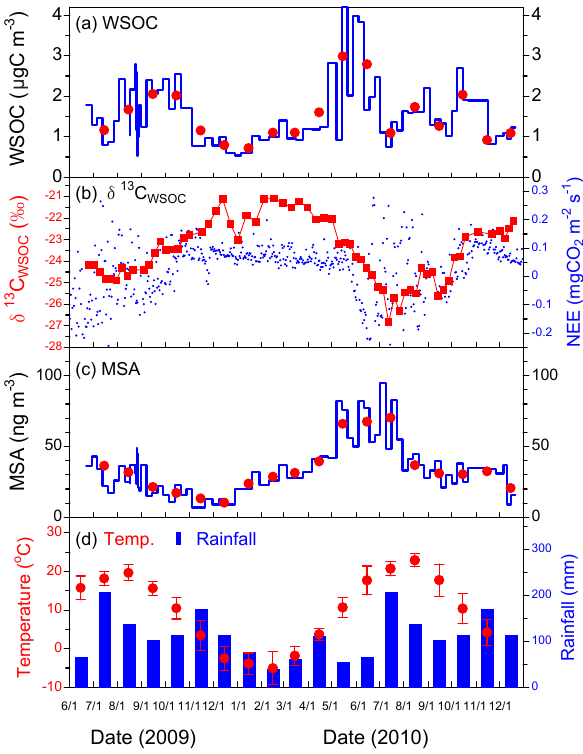
Fig. 2. Temporal variations of (a) WSOC, (b) δ 13 C WSOC (red solid squares) and NEE (blue dots), (c) MSA, and (d) ambient tempera- ture and rainfall near the ground surface at a boreal forest site during the period June 2009–December 2010. The red solid circles in (a) , (c) , and (d) indicate average monthly values. Negative values of NEE in (b) indicate uptake of CO 2 by the forest